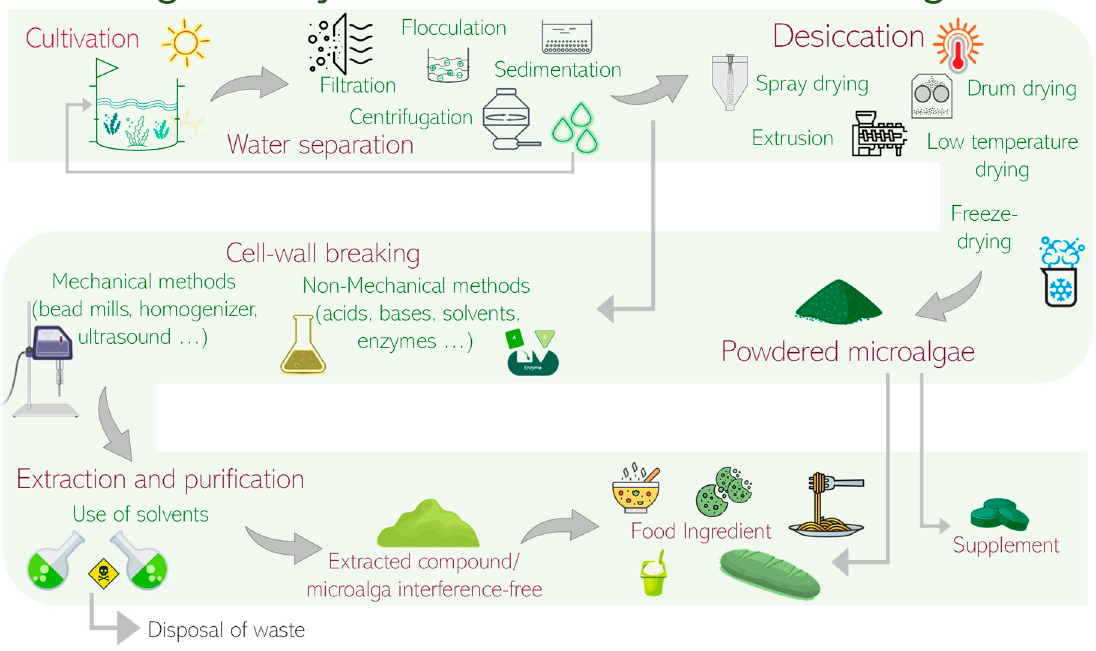
Figure 1. The microalgae production process. All phases leading to use as food ingredients are in- cluded.